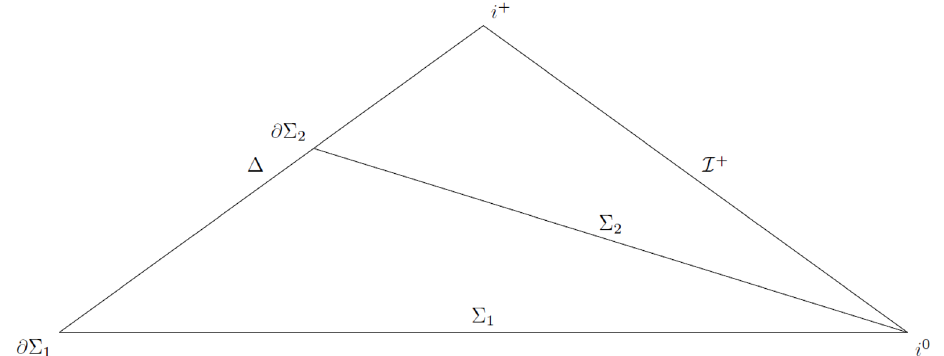
Figure 1 . Part of the space-time that is relevant for the sub-manifold Γ NEH space Γ cov that is of primary interest to our discussion. The inner boundary ∆ is an NEH for each solution g ab in Γ NEH . Σ 1 and Σ 2 are partial Cauchy surfaces that intersect ∆ in 2-spheres ∂ Σ 1 and cov ∂ Σ 2 , respectively. Although this figure includes the asymptotic region including I + and i o , only a neighborhood of ∆ is relevant for our detailed